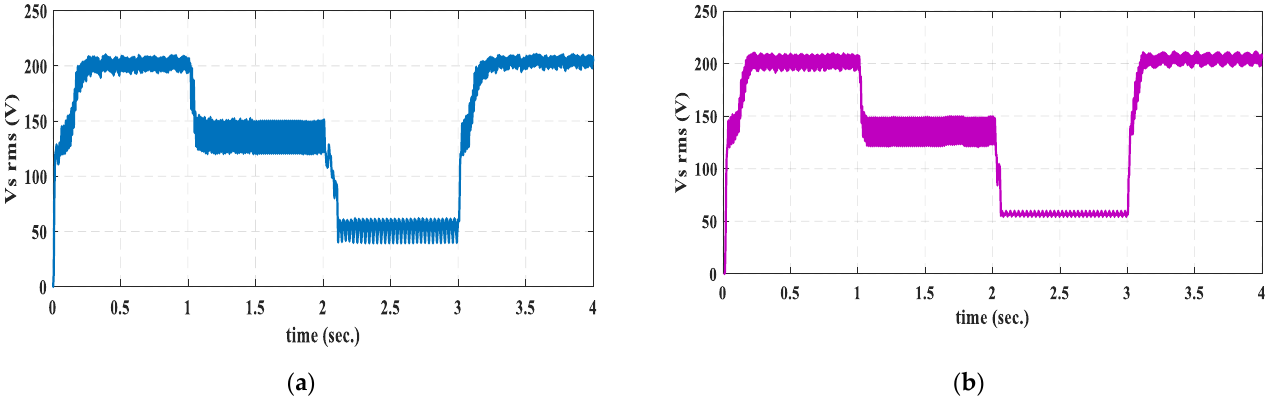
Figure 10. Stator voltage–time response: ( a ) with 3-phase inverter and transformer, ( b ) with 6-phase inverter.